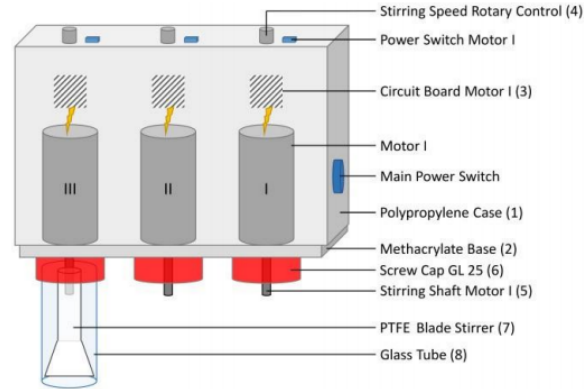
Figure 2. Schematic representation of the equipment employed for the quantification of cellulose dissolution. The equipment parts included: mini-motors with controlled rotation speed connected to a PTFE blade through a screw cap. Dissolution occurs in a glass tube equipped with a thread. The glass tubes are immersed in a controlled temperature water bath [15].